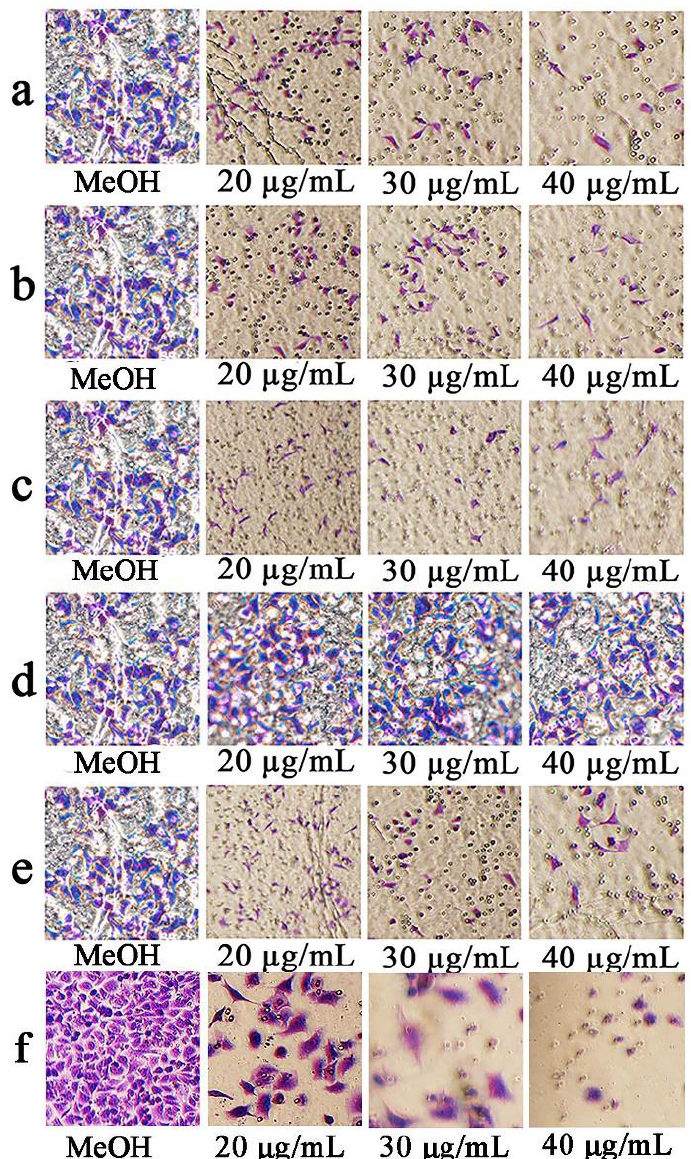
Figure 6. Cell invasion assays. ( a – f ) show the effects of different concentrations (20 µ g/mL, 30 µ g/mL and 40 µ g/mL) of compounds 1 to 5 and cisplatin on the invasion of A549 cells, respectively.